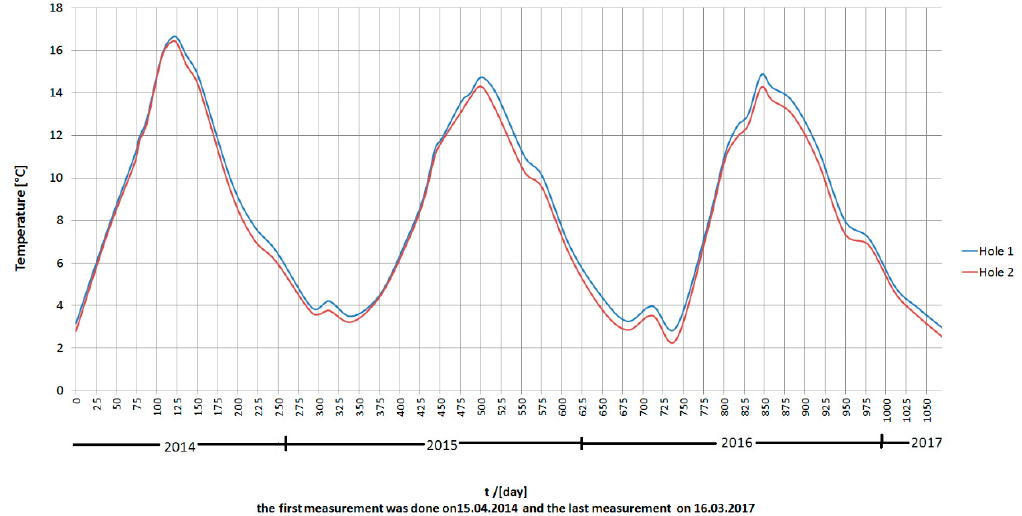
Figure 5. The temperatures in the soil at a 1.5 m depth under the asphalt layer.